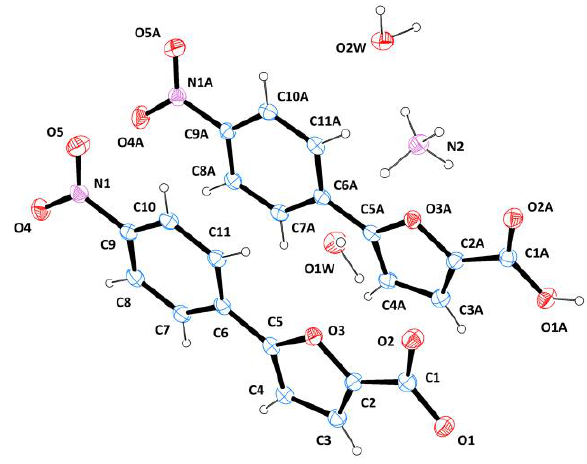
Figure 1. ORTEP diagram of 1 , with the arbitrary atom numbering scheme. Displacement ellipsoids are drawn at the 40% probability level.